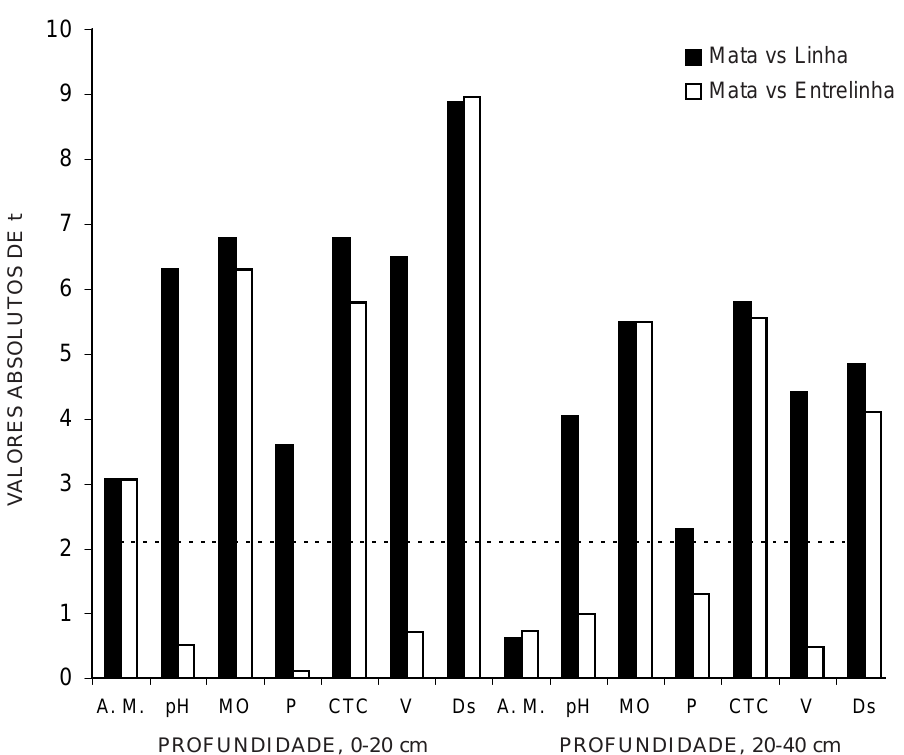
Figura 8. Valores absolutos de t para as variáveis estudadas. A.M. = Atividade microbiana; Ds = densidade do